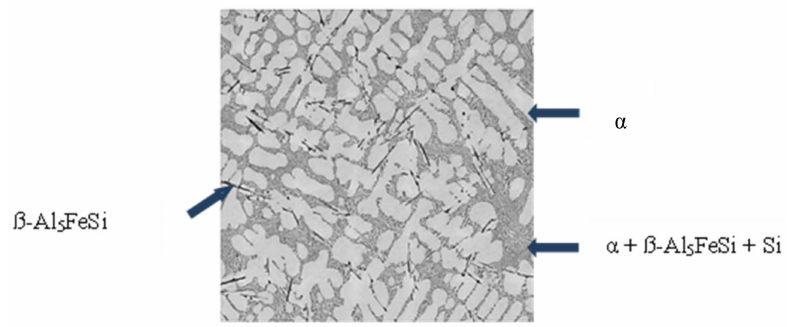
Figure 17. Microstructure of the Al–7%Si–1%Fe alloy.